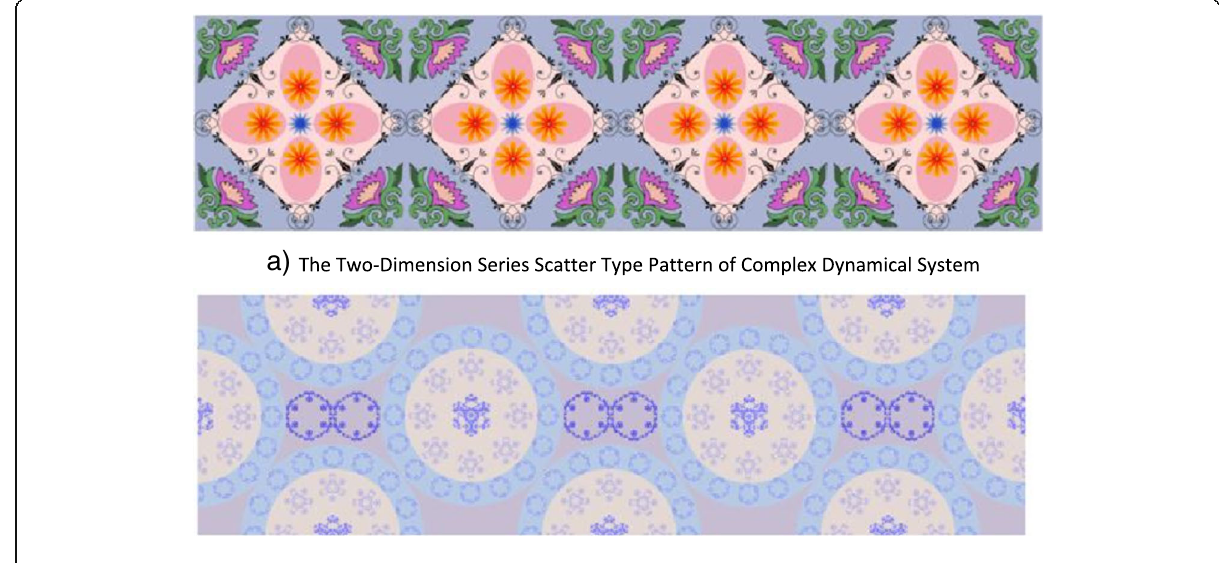
Fig. 11 The two-dimension series scatter-type pattern